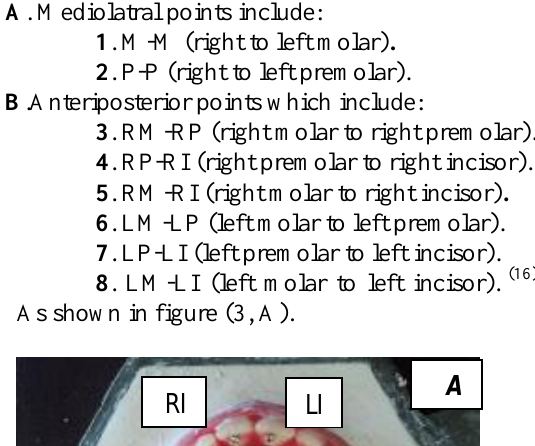
Figure 4, B: the reference point for posterior palatal